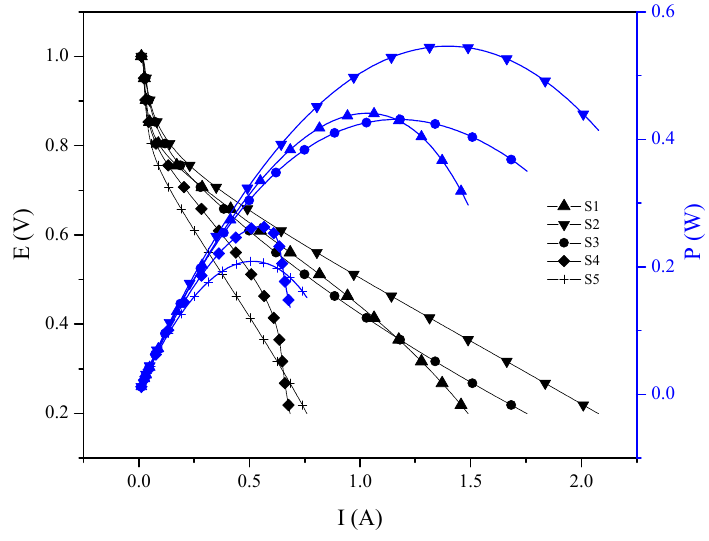
Figure 7. PEMFC Room temperature, P abs = 1 atm, F H2 = 120 mL min − 1 , F O2 = 300 mL min − 1 , 100% RH. Table 4. ohmic resistance at 30 °C.